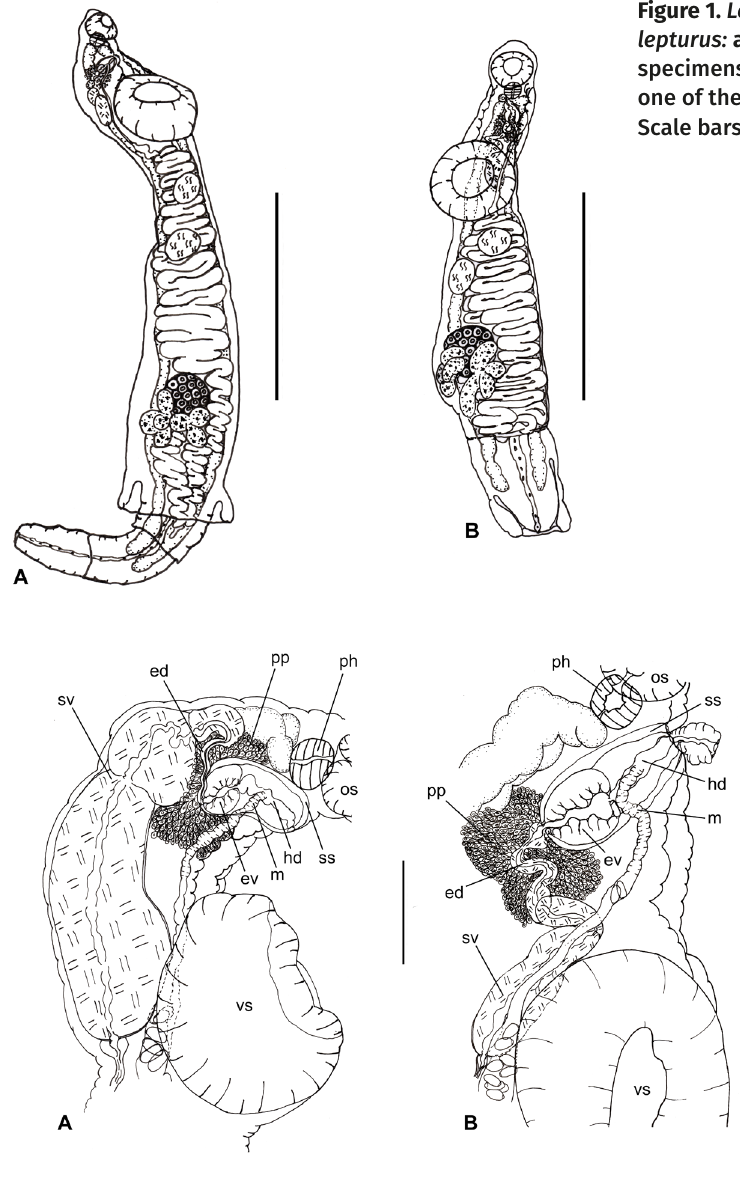
Figure 1. Lecithochirium monticellii from Trichiurus lepturus: a , Entire worm of one of the larger specimens, ventro-lateral view. b , Entire worm of one of the smaller specimens, ventro-lateral view.